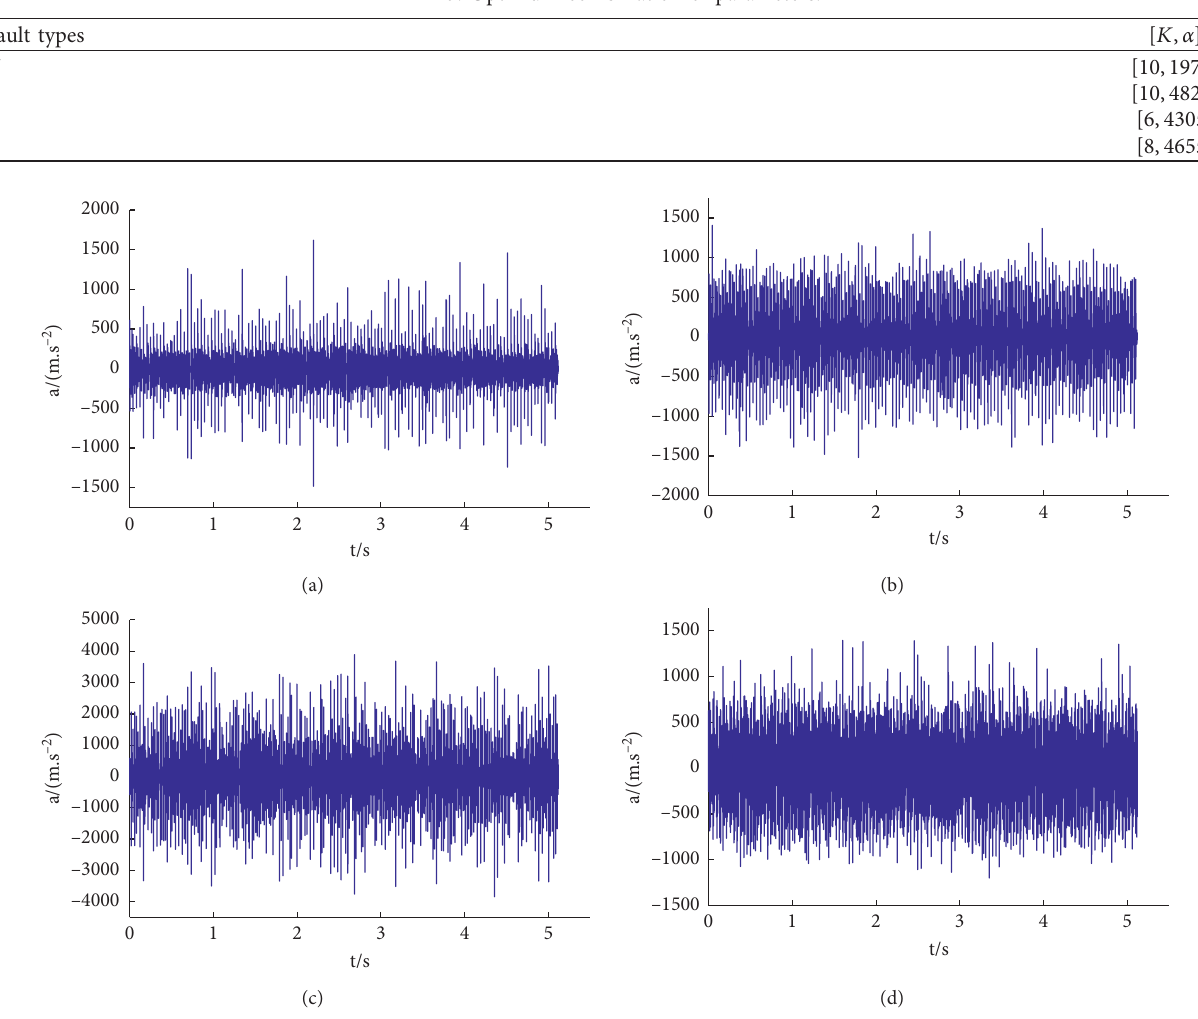
Table 3: Optimum combination of parameters.